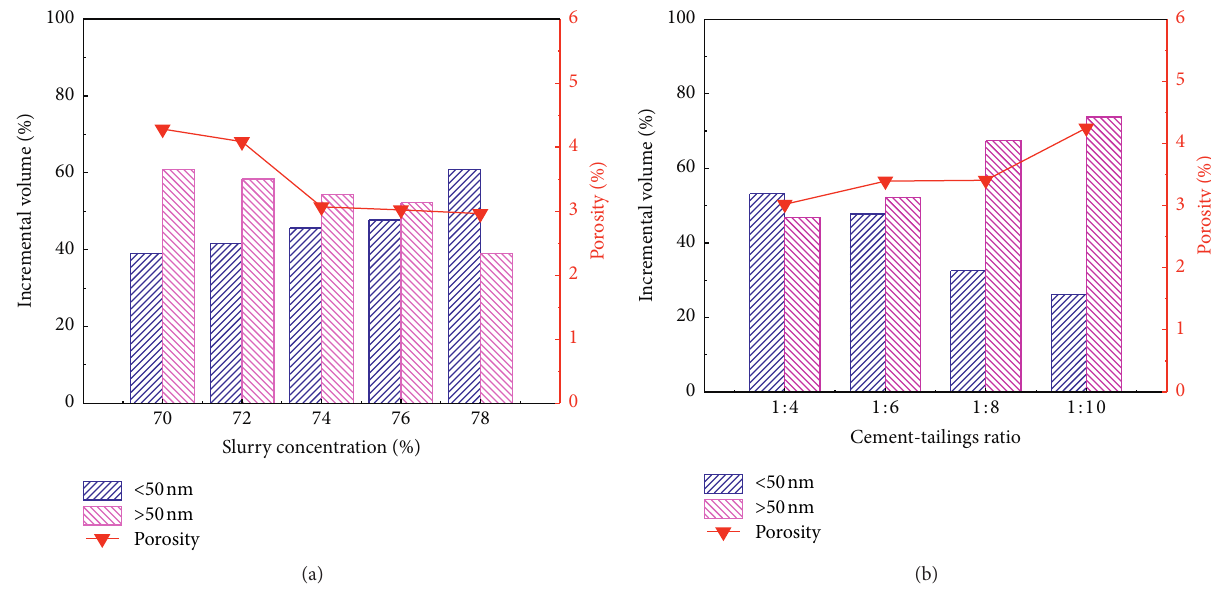
Figure 4: Porosity and pore size distribution of CPB. (a) Slurry concentration effect; (b) cement-tailings ratio effect.